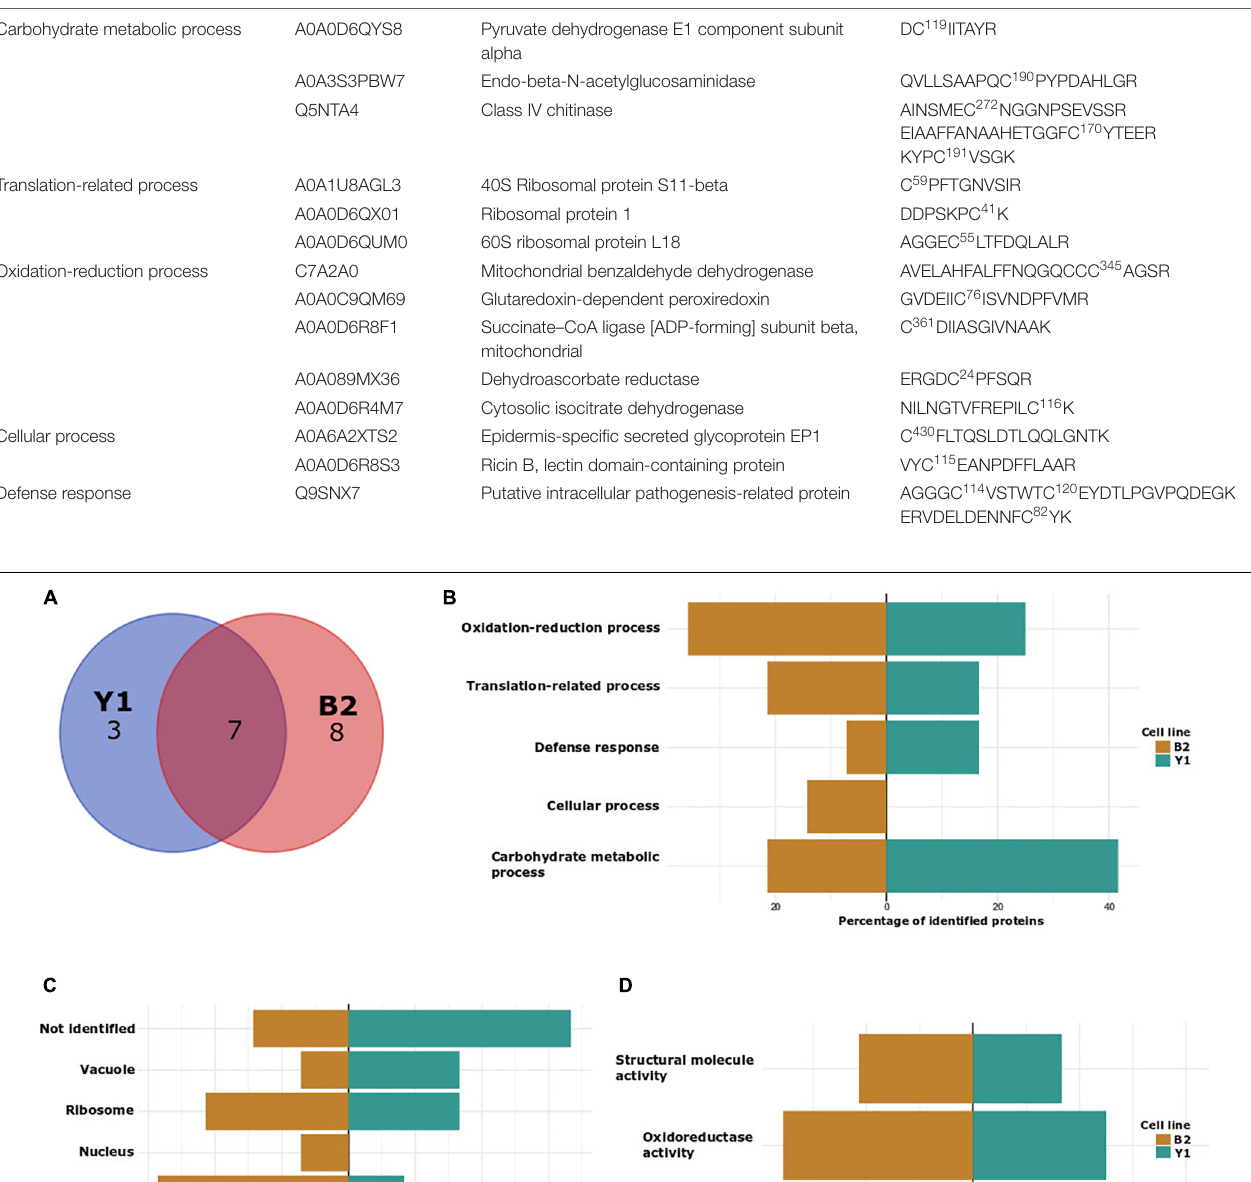
TABLE 4 | Putative S -nitrosated proteins and cysteines sites identified by iodo-TMT reagent from cell line B2, after 2 months of cultivation on maturation medium MSG (Becwar et al., 1989) supplemented with sucrose, sorbitol, ABA and solidified with 1% (w/v) Gellan gum. GO biological process